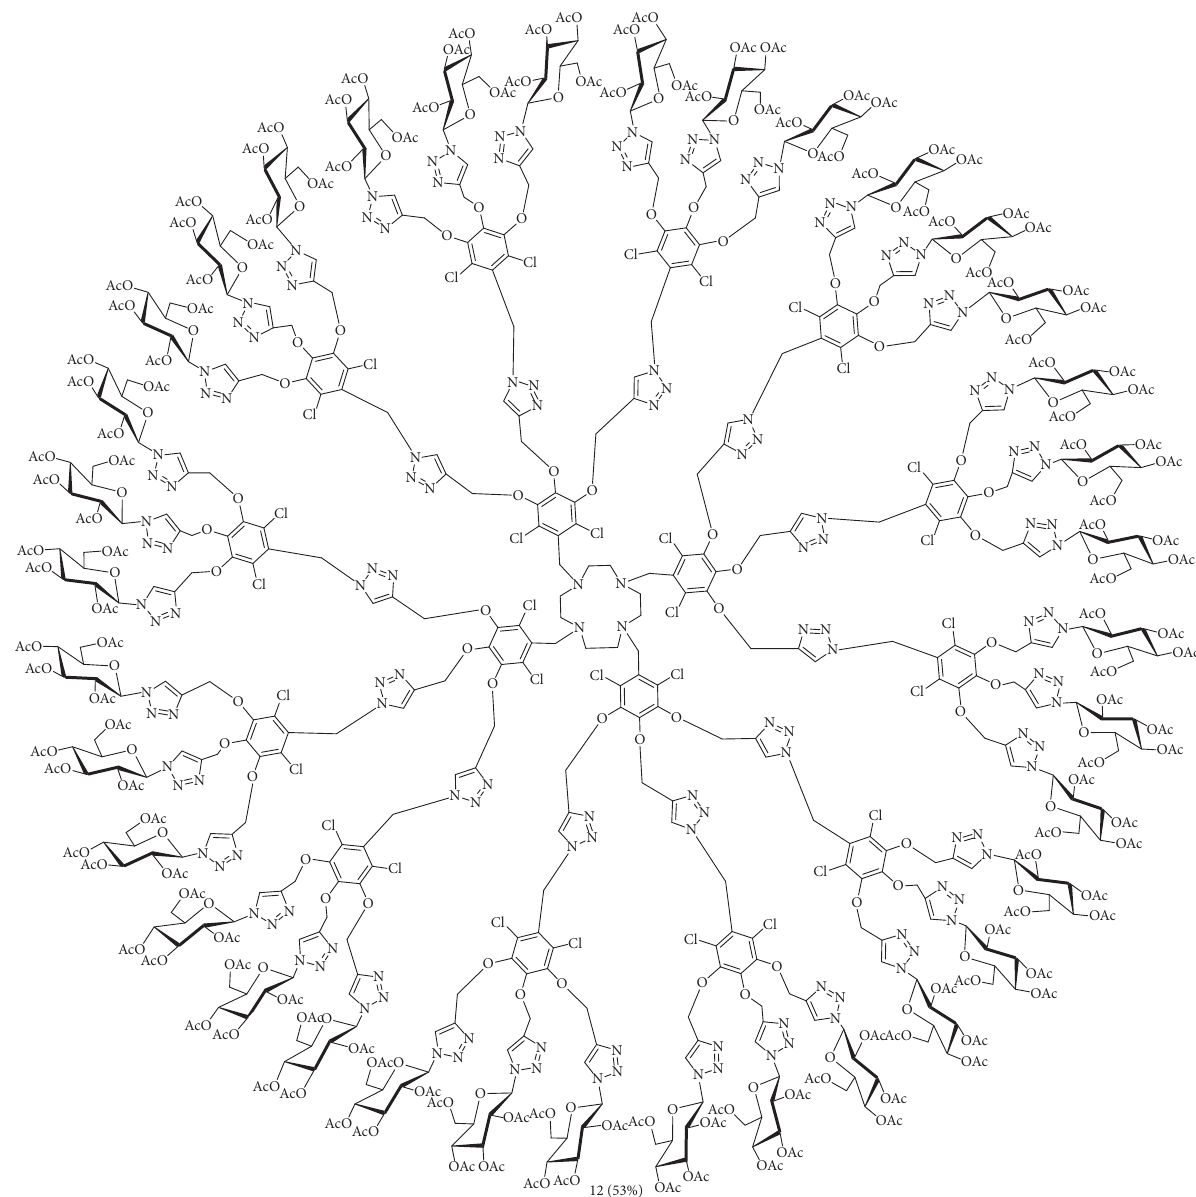
Figure 1: Structure of 36-glucose-coated chlorine-containing cyclen-cored glycodendrimer